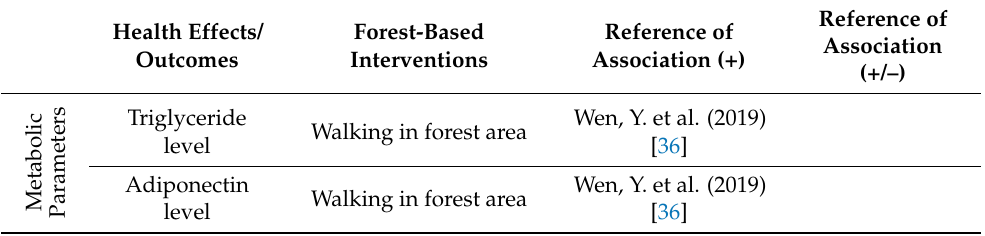
Table 5. Summary of associations between forest-based interventions and health effects/outcomes in metabolic parameters.